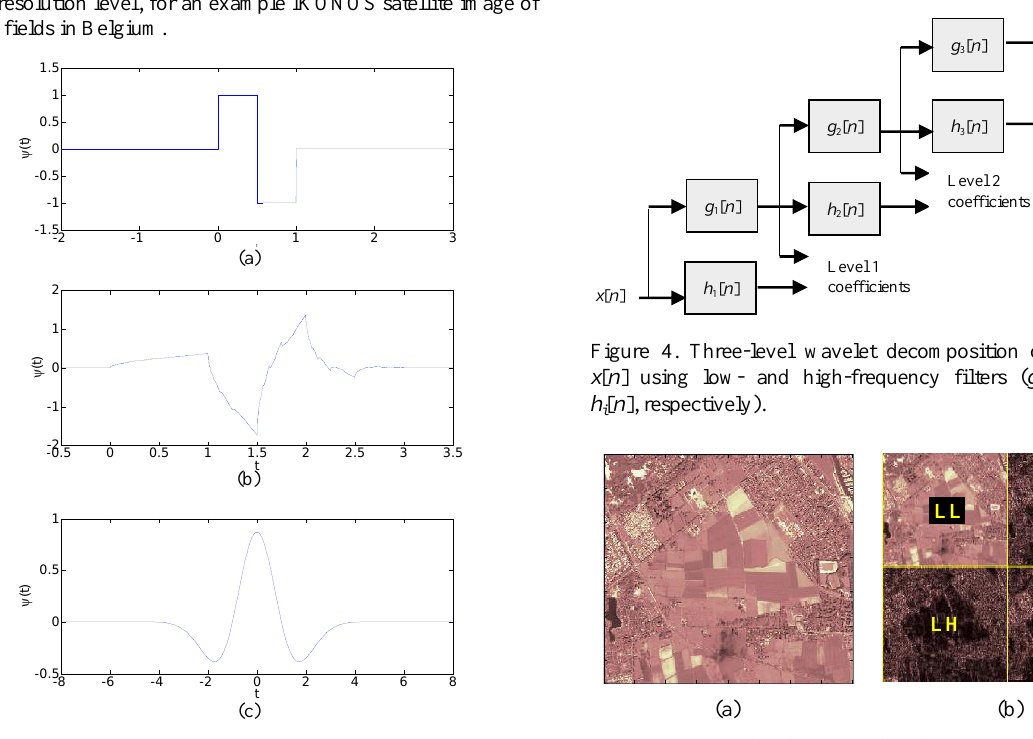
Figure 3. Example wavelet decomposition for a one-dimensional signal. (a) Input signal, which is actually a horizontal row of pixel values taken from an NDVI image of the area under study (Section 4). (b) Level-1 approximation coefficients. (c) Level-1 detail coefficients. Notice that (b) follows the general trend of the original signal, whereas (c) contains information related to finer details only.